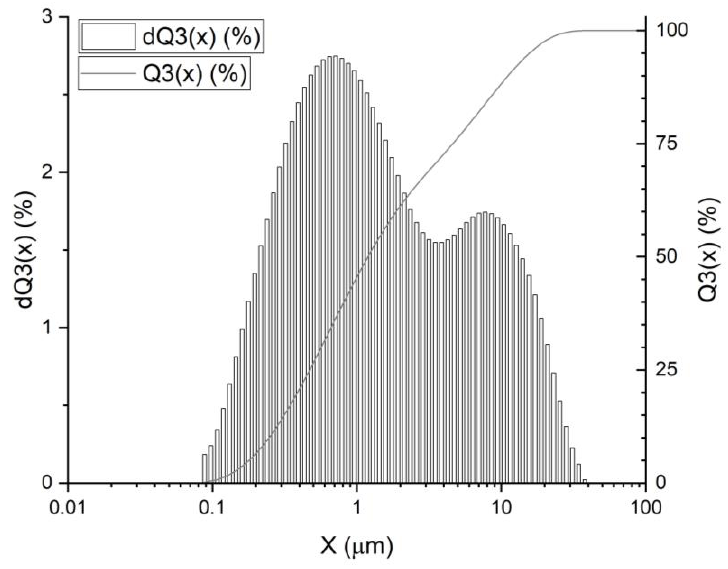
Figure 1. Particle size distribution of the native dust.